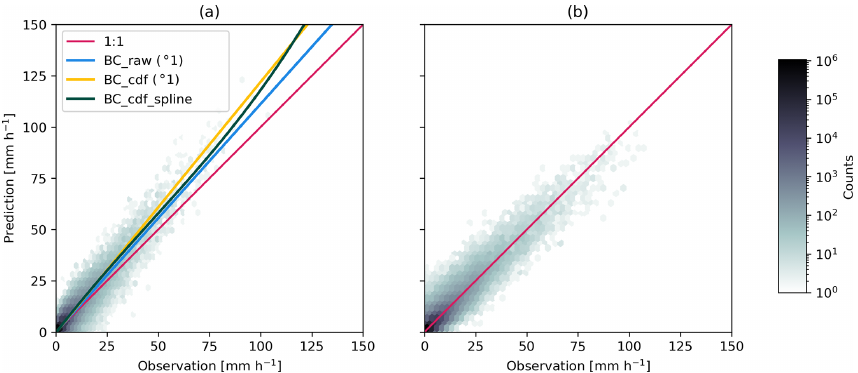
Figure 3. Panel (a) shows an example of raw uncorrected predictions (as a density plot) versus observations on the training fraction. The blue, yellow and dark green lines are the corresponding fitted bias-correction models which try to estimate the observed value as a function of raw predicted values. Panel (b) shows the raw predictions corrected with the BC_cdf_spline method (dark green line in panel a ), which brings them much closer to the 1 : 1